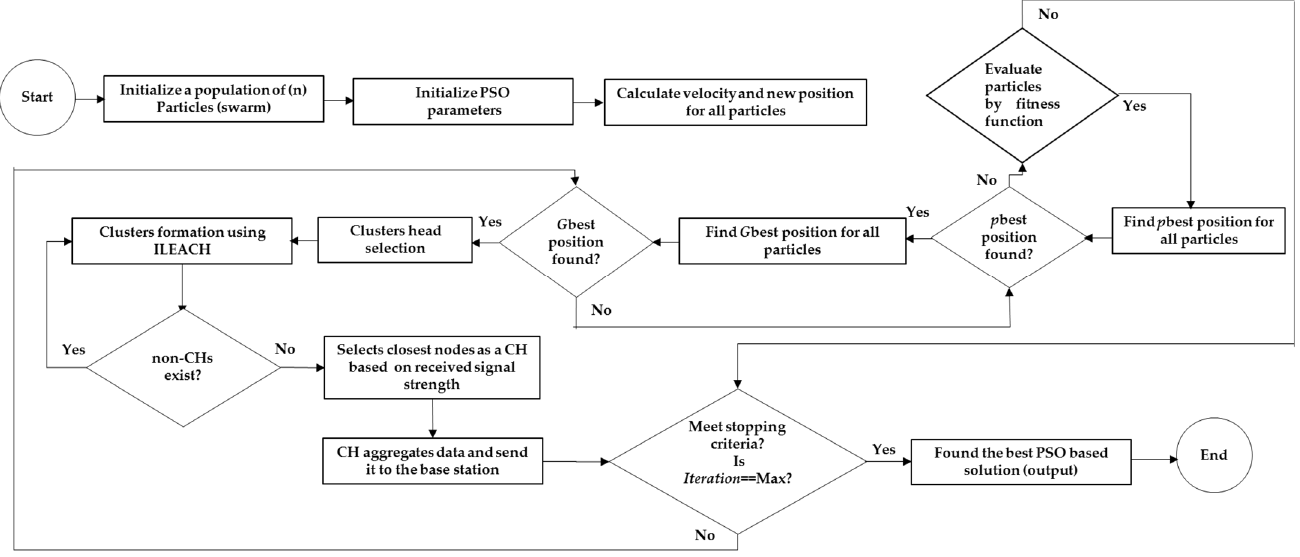
Figure 7. Proposed work methodology.